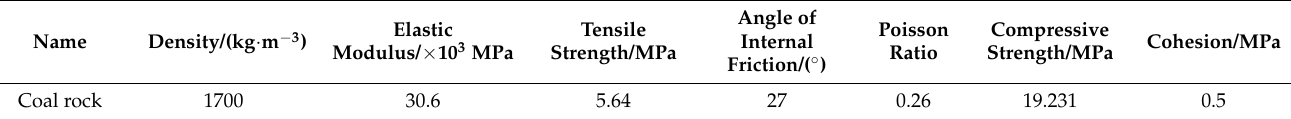
Table 5. Coal rock mesoscopic parameter table.